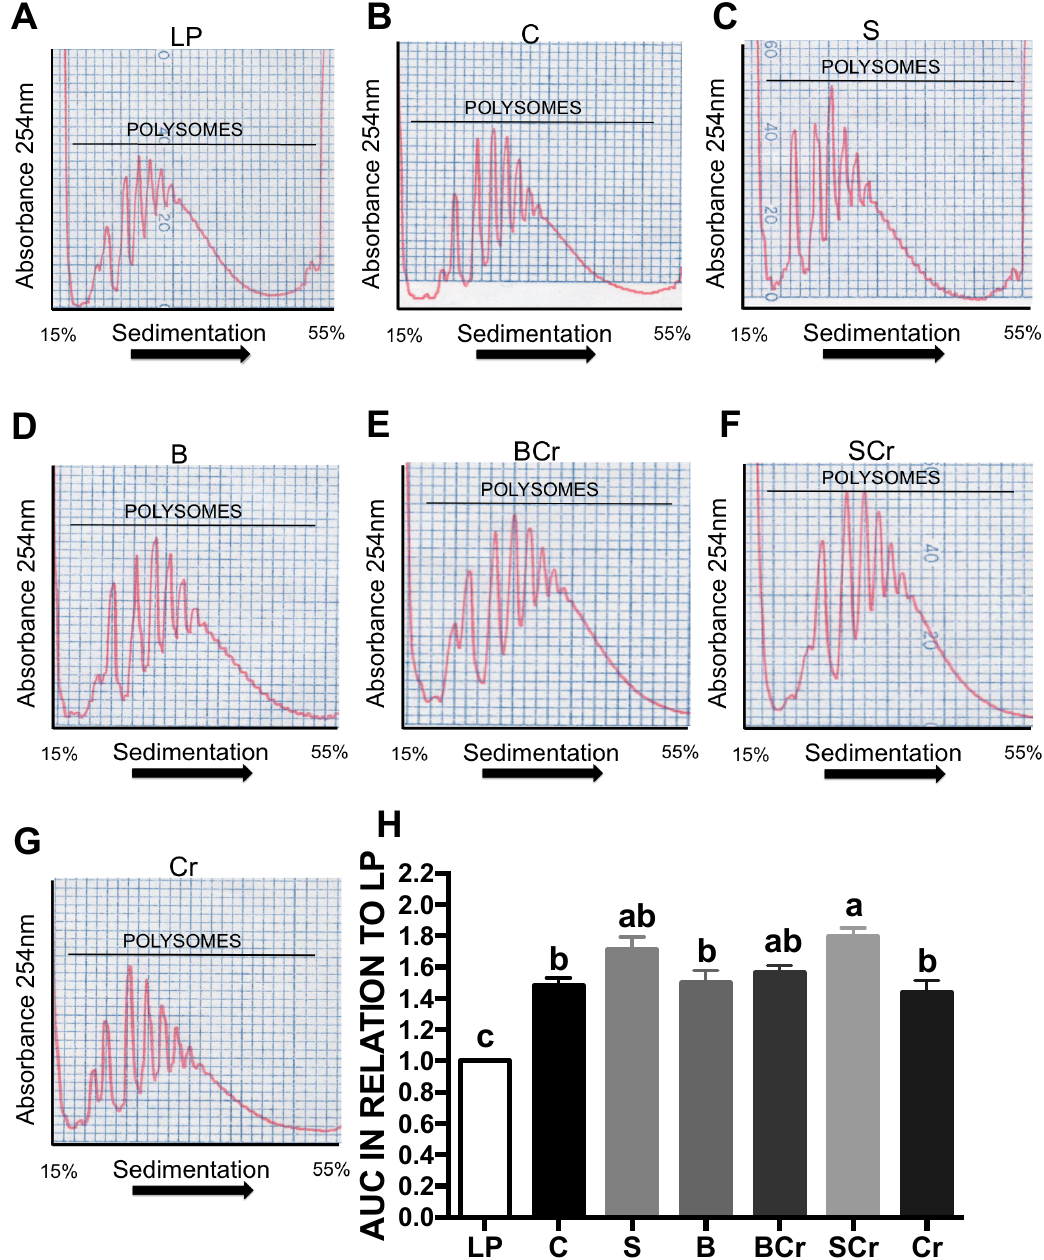
Figure 9. Hepatic polysome profile of rats fed different types of dietary proteins after a protein restricted period: ( A ) 0.5% casein; ( B ) casein; ( C ) soy; ( D ) black bean; ( E ) black bean + corn; ( F ) soy + corn; ( G ) corn; and ( H ) area under the curve analysis. The values are mean ± SEM, n = 3 per group. Different letter superscript indicates significant differences among groups, p < 0.05, a > b > c.